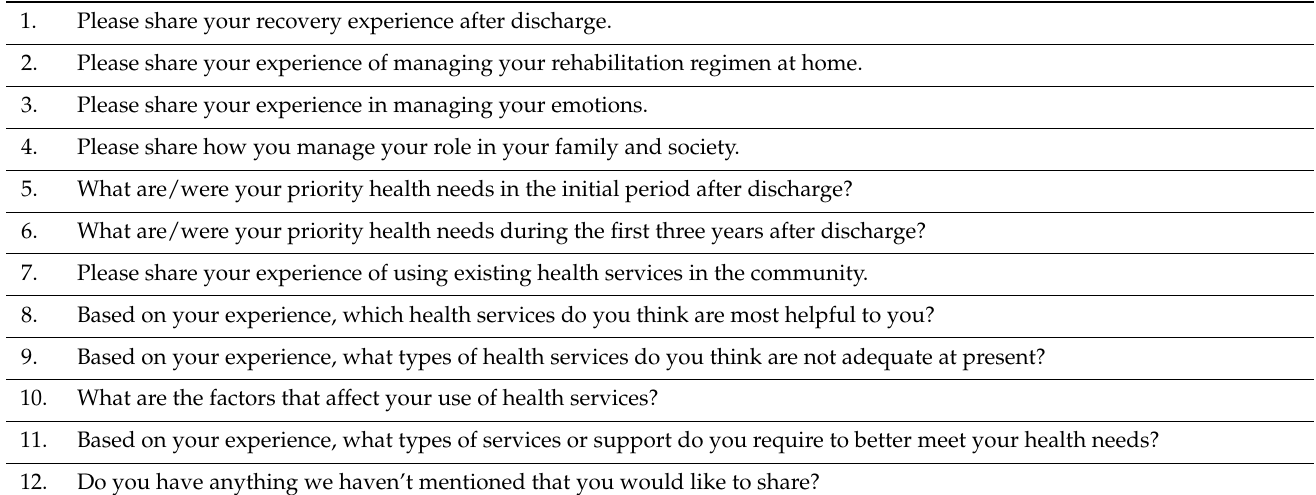
Table 1. Questions in semi-structured interview